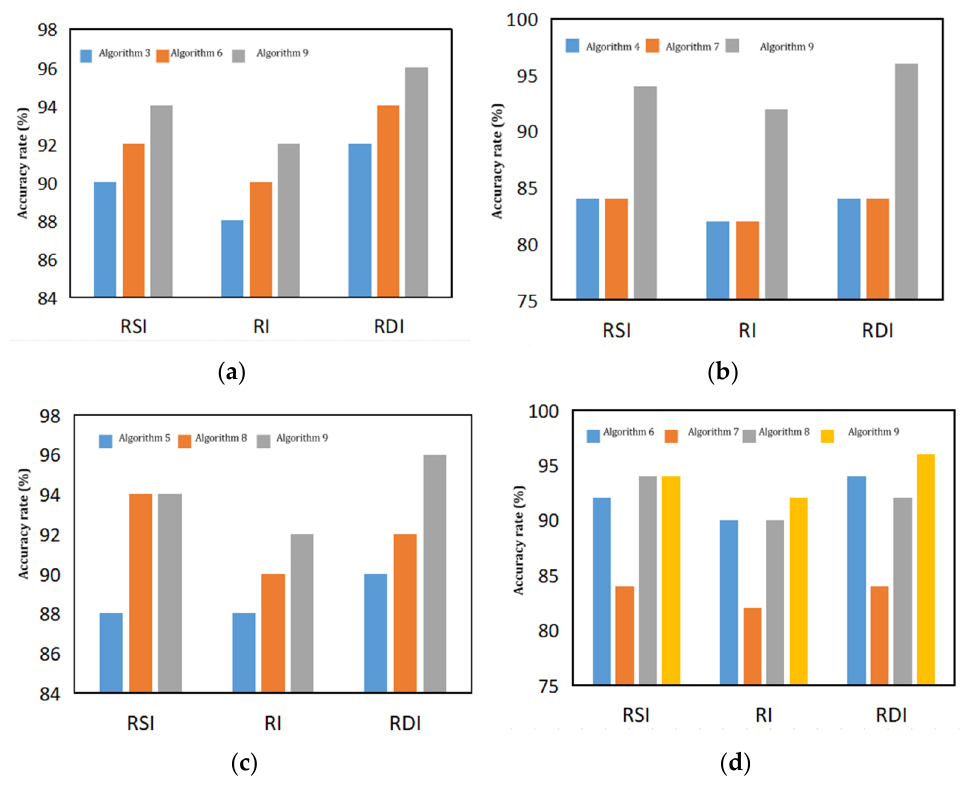
Figure 6. Algorithm 3, 4, 5, 6, 7, 8, 9 forecast accuracy comparison. ( a ) Comparison of forecast accuracy of algorithms 3, 6 and 9. ( b ) Comparison of forecast accuracy of algorithms 4, 7 and 9. ( c ) Comparison of forecast accuracy of algorithms 5, 8 and 9. ( d ) Comparison of forecast accuracy of algorithms 6, 7, 8 and 9.